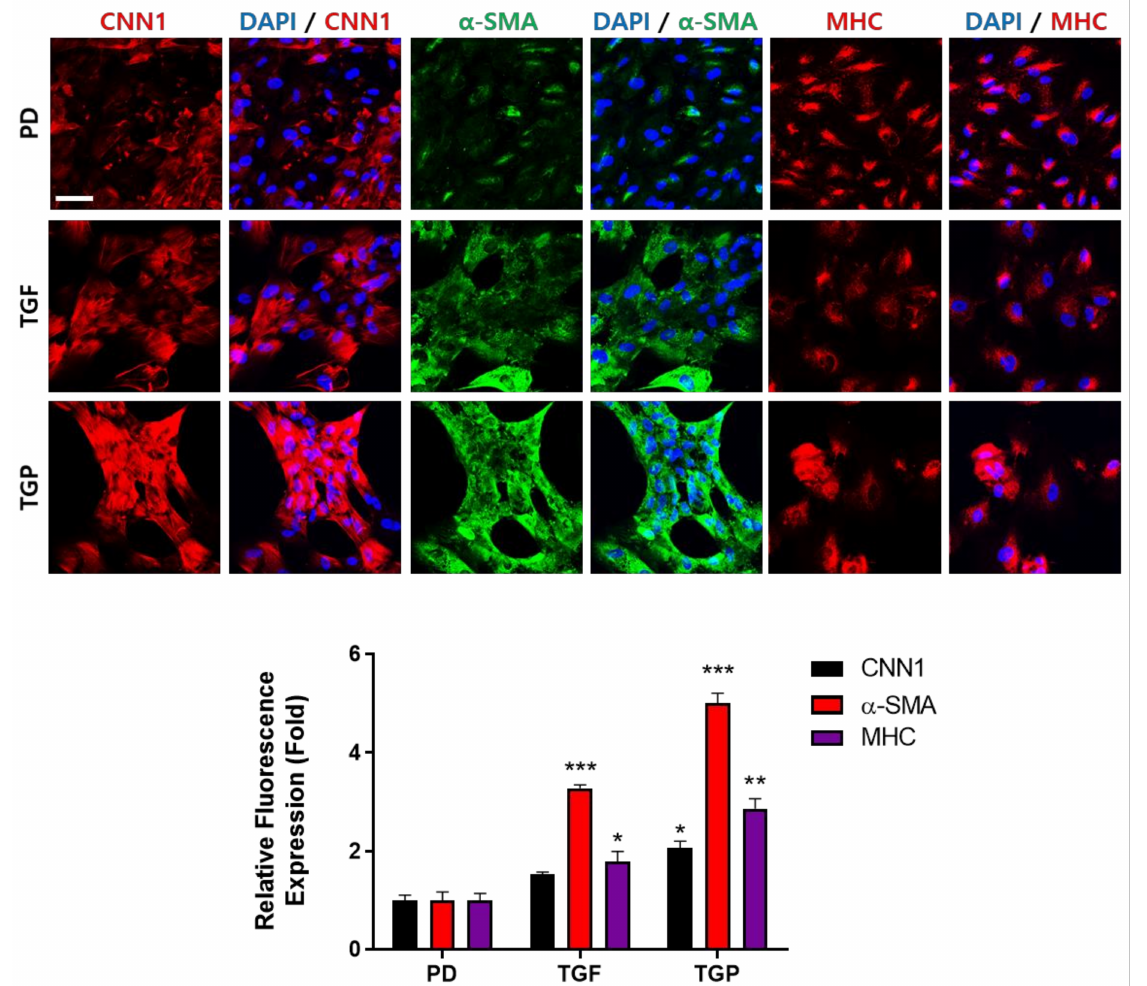
Figure 5. Immunocytochemical analysis of α -SMA, CNN1, and SM-MHC protein expression in differentiated SMCs: PD; PD98059, TGF; TGF- β 1, TGP; PD98059 and TGF- β 1. Scale bar indicates 50 µ m: * p < 0.05, ** p < 0.01, *** p < 0.005, * vs.